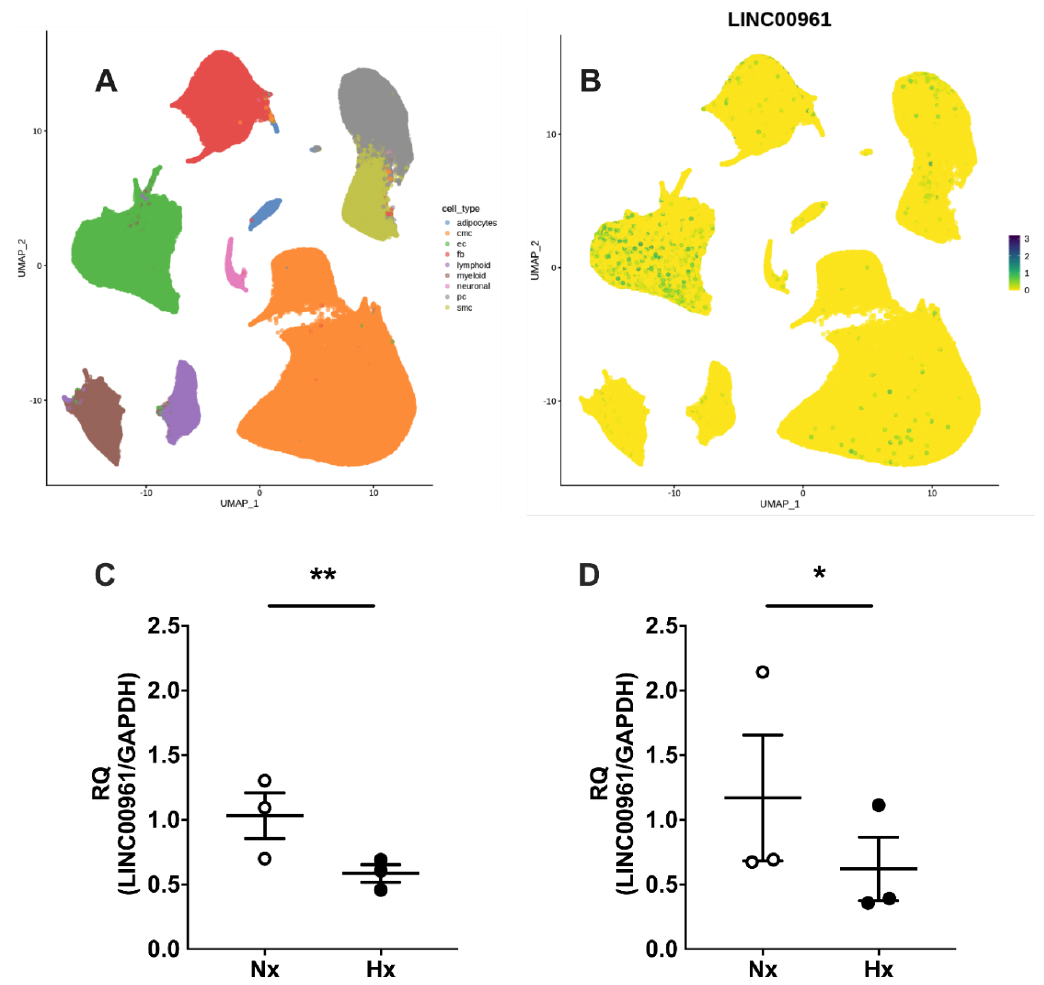
Figure 1. Human cardiac SPAAR (small regulatory polypeptide of amino acid response) expression and LINC00961 response to hypoxia. Uniform manifold approximation and projection for dimension reduction (UMAP) visualisation of ( A ) human cardiac endothelial cells (EC, green), fibroblast (FB, red), pericyte (PC, grey), SMC (olive), cardiomyocyte (CMC, orange), adipocyte (blue), neuronal cell (pink), myeloid (brown), and lymphoid (purple) fraction [19], and ( B ) SPAAR expression in human cardiac cell populations. LINC00961 expression is reduced in bEnd.3 mouse cells following 24 h ( C , black n = 3) and 48 h ( D , black n = 3) exposure to hypoxia (H, 1% O 2 ) compared with bEnd.3 cells cultured in normoxia (Nx, 5% O 2 ) collected in parallel (both n = 3). Student’s t-test. Data are mean ± SEM. * p < 0.05, ** p < 0.01.